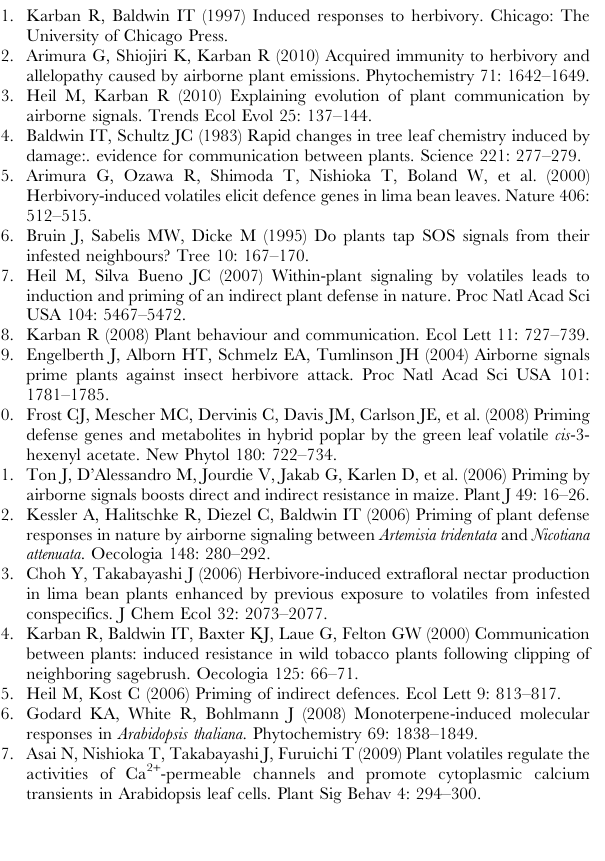
represent the mean + standard errors (n =41–47). Asterisks indicate significant differences between VOCwt and